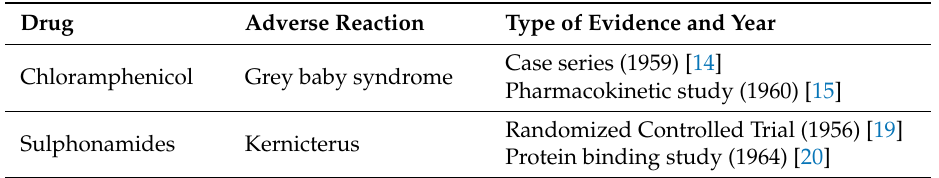
Table 1. Drug toxicity in